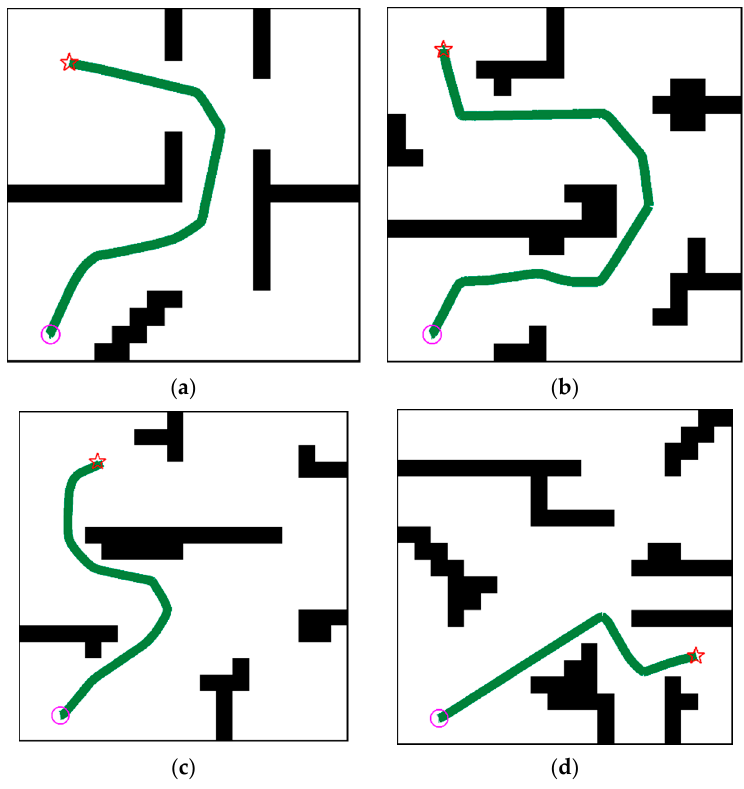
Figure7. Examplesoftherobotcompletingonenavigationtasksinthetrainingandtestingenvironments. The light purple circle denotes the starting point and the red pentagram denotes the goal point. The dark green lines are the trajectories generated by MK-A3C. For clear presentation, we do not show trajectories of moving obstacles. ( a ) Training Environment; ( b ) Testing Environment 1; ( c ) Testing Environment 2; ( d ) Testing Environment